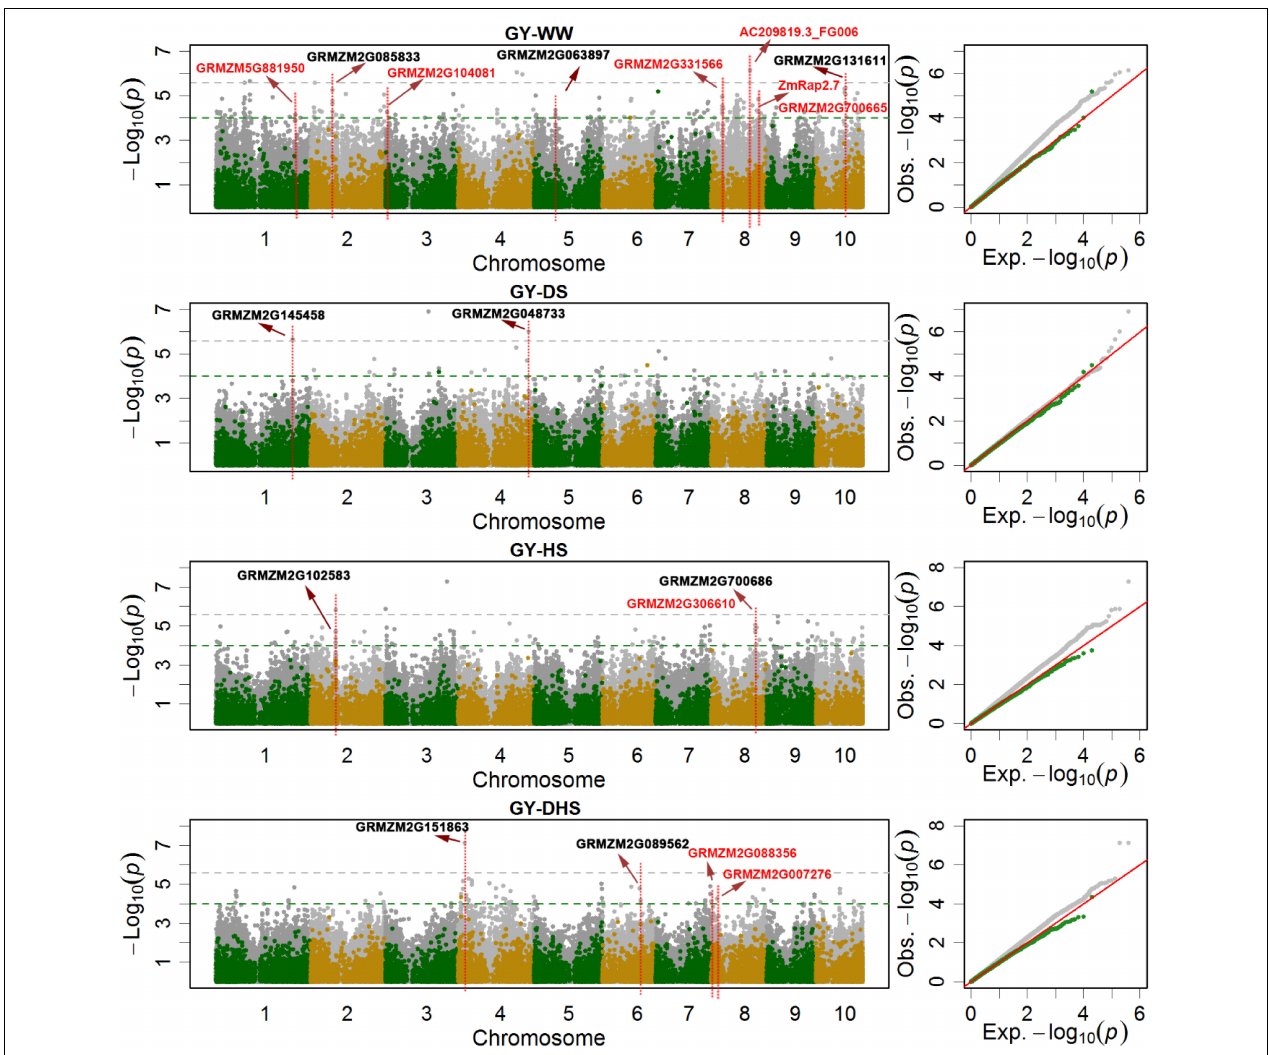
FIGURE 3 | The Manhattan plots and Q-Q plots of the SNP-based (gray dots) and the haplotype-based (green and yellow dots) association mapping for grain yield (GY) under different conditions. WW, DS, HS, and DHS are abbreviated from well-watered, drought stress, heat stress and combined drought and heat stress management conditions. The red colored candidate genes are the previously reported, and the blank colored are novel candidate